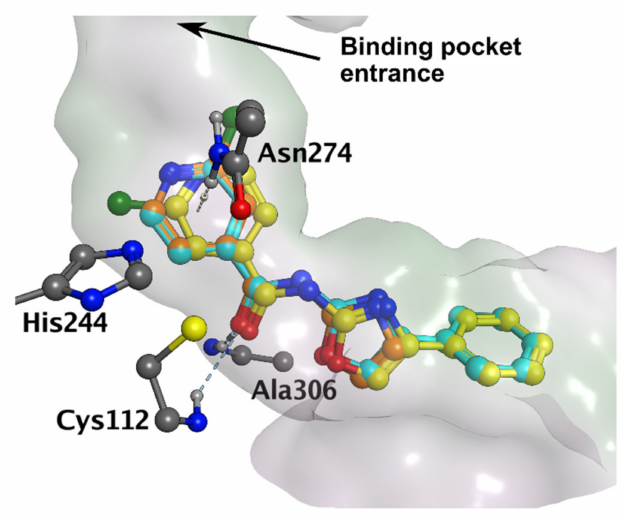
Figure 3. Binding mode 1 of 6b (orange) and 15b (yellow and cyan) in MtFabH (PDB ID: 1U6S), non-interacting hydrogens hidden for clarity. Table 4. Interactions of binding mode 1 observed in the docking